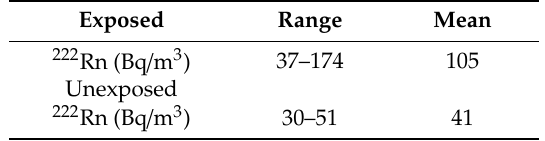
Table 3. Indoor radon levels obtained in occupied dwellings at various